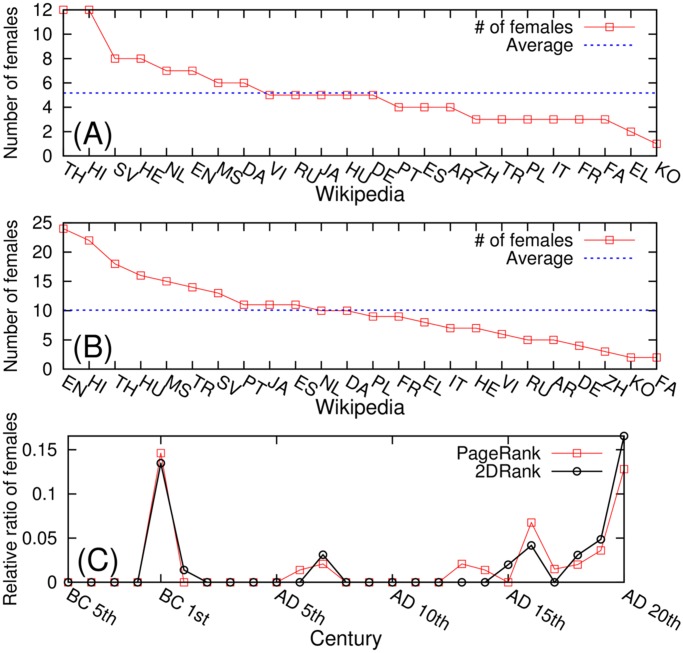
Number of females of top historical figures from each Wikipedia edition (A) Top PageRank historical figures (B) Top 2DRank historical figures.(C) The average female ratio of historical figures in given centuries across 24 Wikipedia editions.